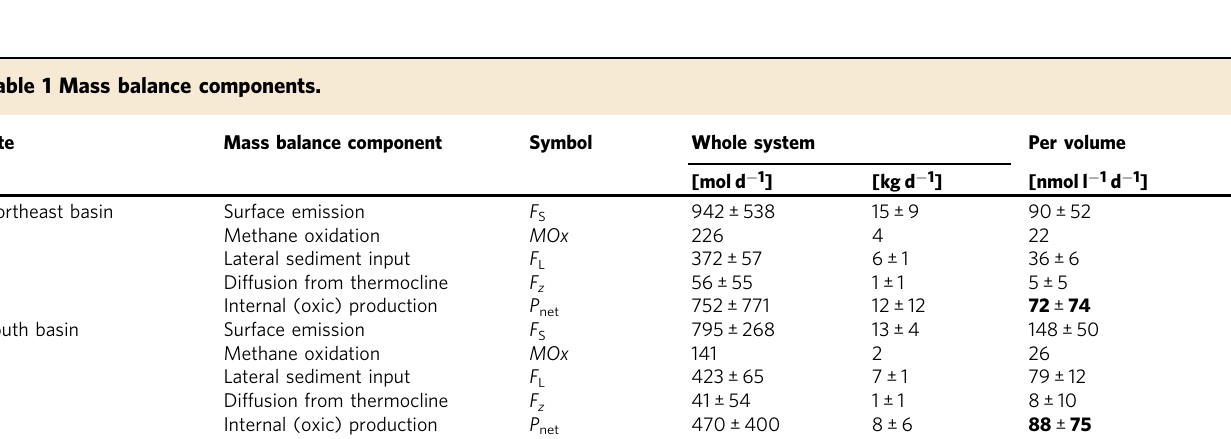
Oxic production was computed by measuring/estimating surface emission, oxidation, lateral input, as well as vertical diffusion (see Fig. 1) and solving the mass balance for the missing component Seven replicate measurements were taken in the open water of the Northeast (69.5m deep; surface area 2,006,700m 2 ; 53°09'20.2''N 13°01'51.5''E) and South basin (20.5m deep; surface area simulationweretobeappliedtowholelakedata(combiningSouthandNortheast basinsdata),oxicmethaneproductionrates(denotedas P net inEq. (1)) donotchange:78±80nmoll − 1 d − 1 ( F S = 2503 ±1160, MOx = 496, F L = 1198±185, F z = 139±170, P net = 1653±1703mold − 1